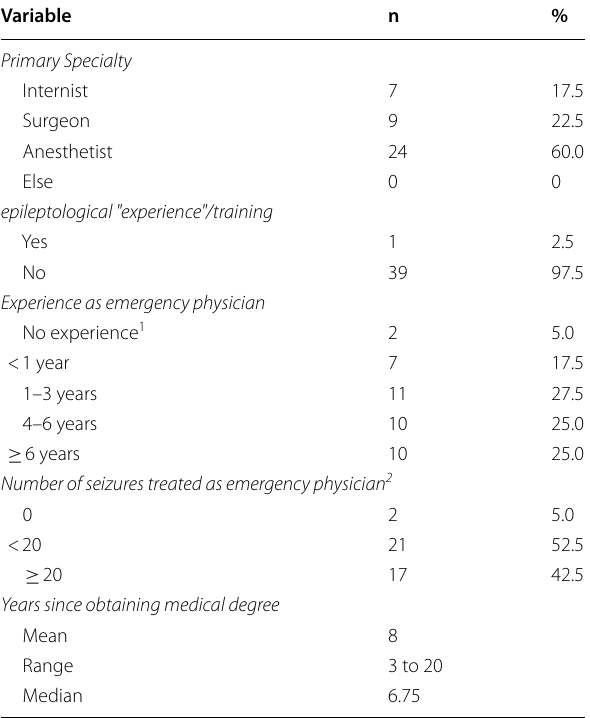
Table 1 Work biographical data of the 40 study